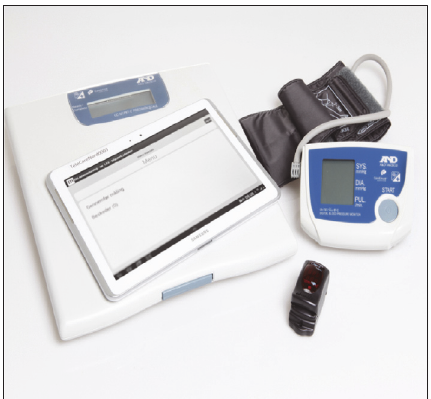
Figure 1: The Telekit system from the Danish TeleCare North trial. The COPD patients use Telekit to measure their vital